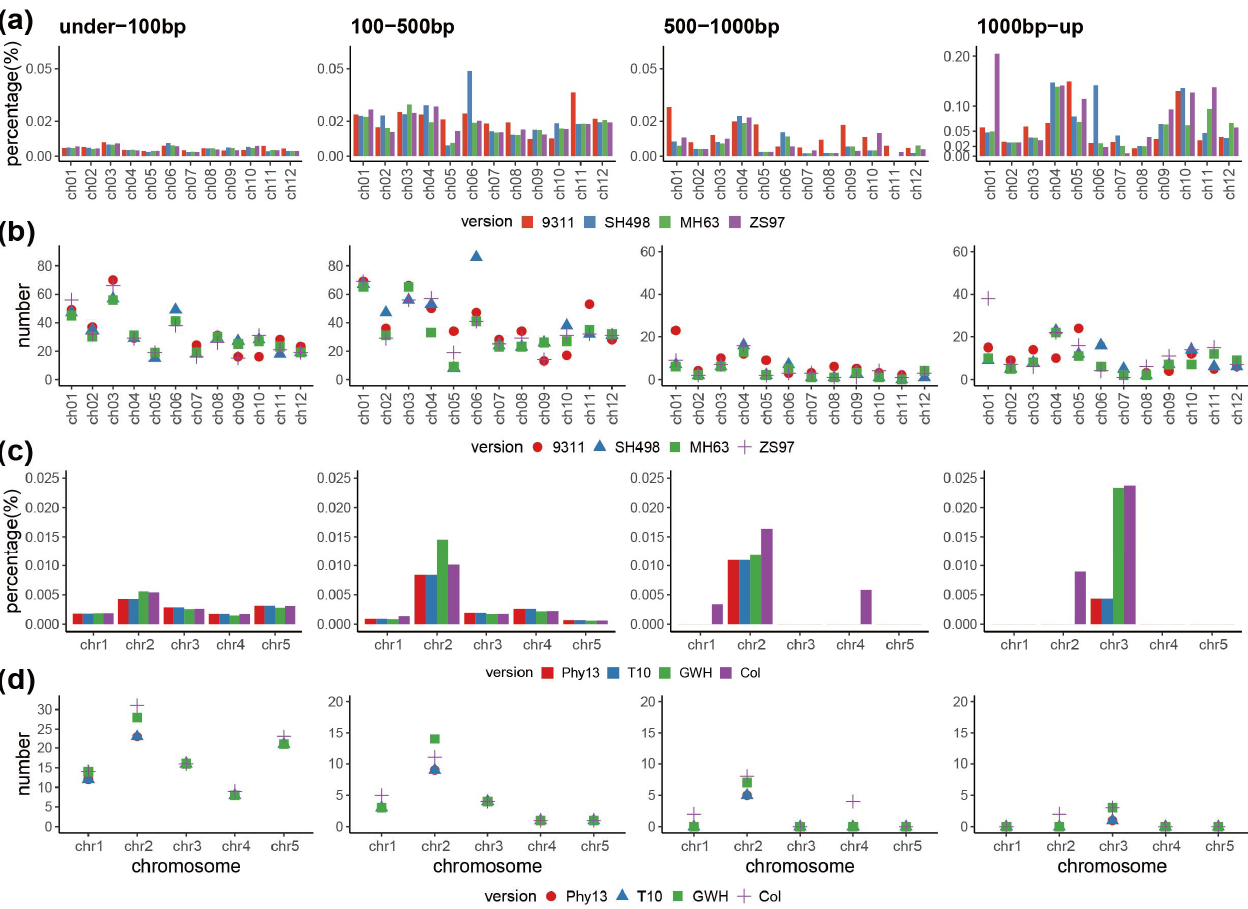
Figure 1. The length ratio and number of transferred plastome sequences in nuclear chromosomes in O. sativa and A. thaliana with 95% and higher identity. ( a ) Length proportion of plastome transfers to nuclear chromosomes in O. sativa across four different size categories. ( b ) The number of plastome sequences transferred to nuclear chromosomes in O. sativa across four different size categories. ( c ) Length proportion of plastome transfers to nuclear chromosomes in A. thaliana across four different size categories. ( d ) The number of plastome sequences transferred to nuclear chromosomes in A. thaliana across four different size categories. The bar charts represent the relative length of all transferred fragments to the total length of each nuclear chromosome as a percent, assembly versions are ordered along the x axis from oldest to